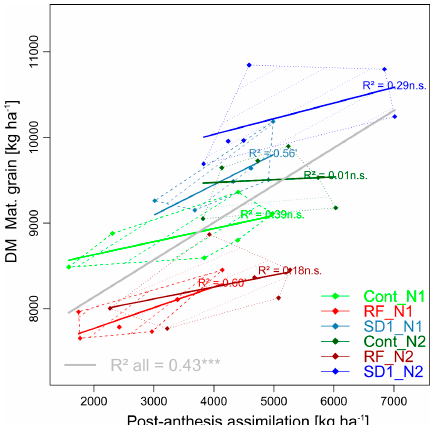
Figure 4. Selected pairwise trait relationship in trait complex c : DM of grain at maturity (GY) in relation to its additive component post-anthesis assimilation (PAA). N levels are distinguished by line types and color intensities (N1: Dashed lines and light colors, N2: Dotted lines and dark colors). Dashed and dotted lines delimit the bivariate data range covered by cultivars within MP × N-combinations. Colored regression lines indicate the linear trait relationships within MP × N-combinations and gray lines the regression line for the whole trial, calculated across the included data of reduced fungicide (RF), control (Cont) and sowing date 1 (SD1). Gray lines are only drawn for significant relationships ( p < 0.05). P -values of regression slopes are indicated as p < 0.01 (***), p < 0.01(**), p < 0.05 (*) and p < 0.1 (´).